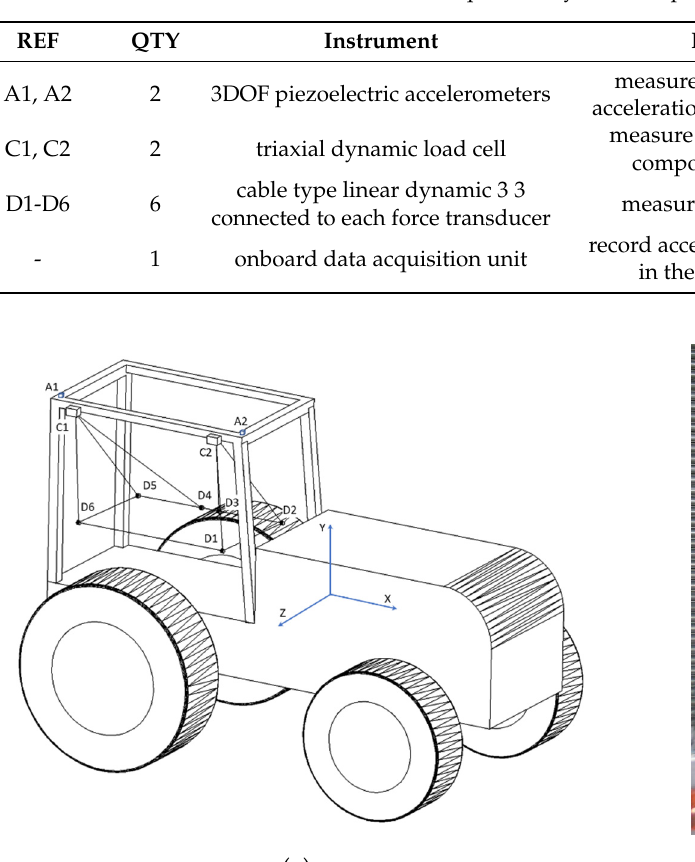
Table 2. Data acquisition system components of the test tractor.